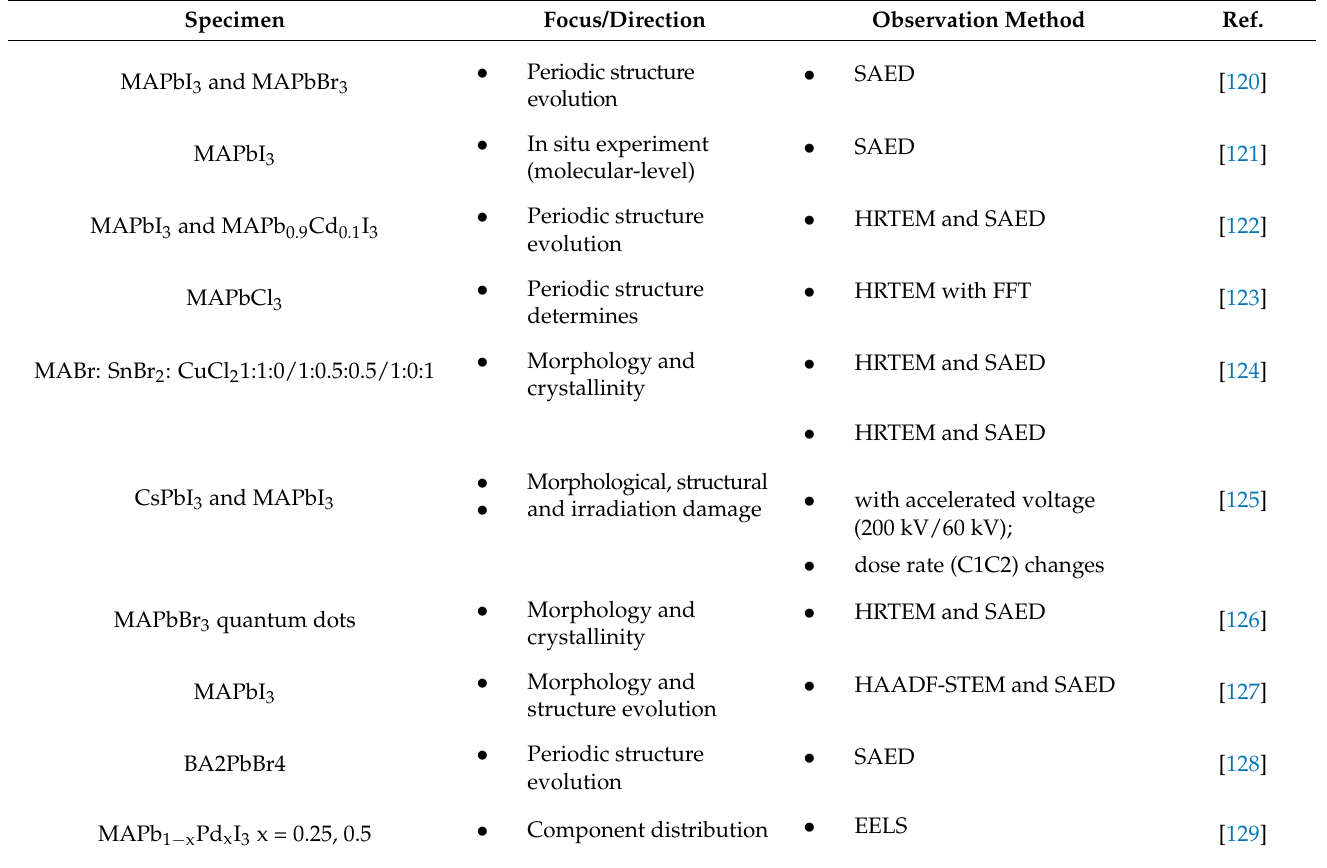
Figure 22. ( a ) HAADFSTEM images of selected areas; ( b ) corresponding iDPC-STEM images. The white box is to highlight and magnify the structure. Reprinted/adapted with permission from Ref. [119]. Copyright 2021, Springer Nature. Table 2. Studies on MAPbI3 electron diffraction or fast Fourier transform patterns in the literature. Specimen Focus/Direction Observation Method Ref. MAPbI 3 and MAPbBr